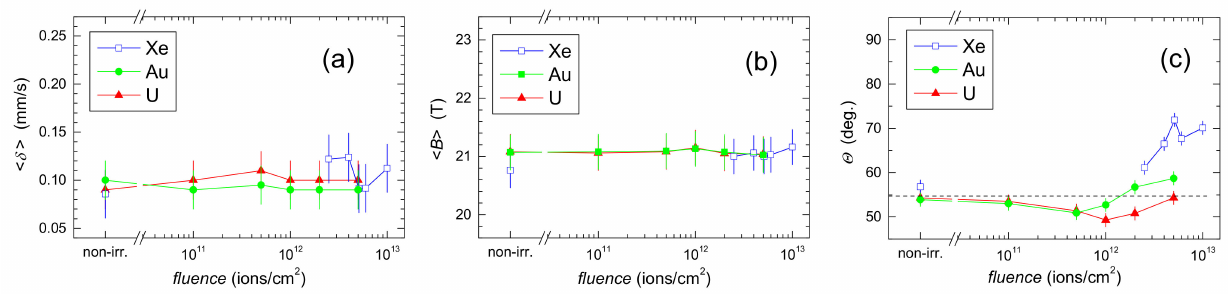
Figure 20. Parameters derived from transmission Mössbauer spectra of Fe 73 Cu 1 Nb 3 Si 16 B 7 amorphous metallic alloy irradiated by the indicated heavy ions: ( a ) average isomer shift, (cid:104) δ (cid:105) ; ( b ) average hyperfine magnetic field, (cid:104) B (cid:105) ; ( c ) angle Θ as a function of ion fluence. Dashed line in ( c ) represents Θ -values that correspond to random orientations of spins. Solid lines are only guides for the